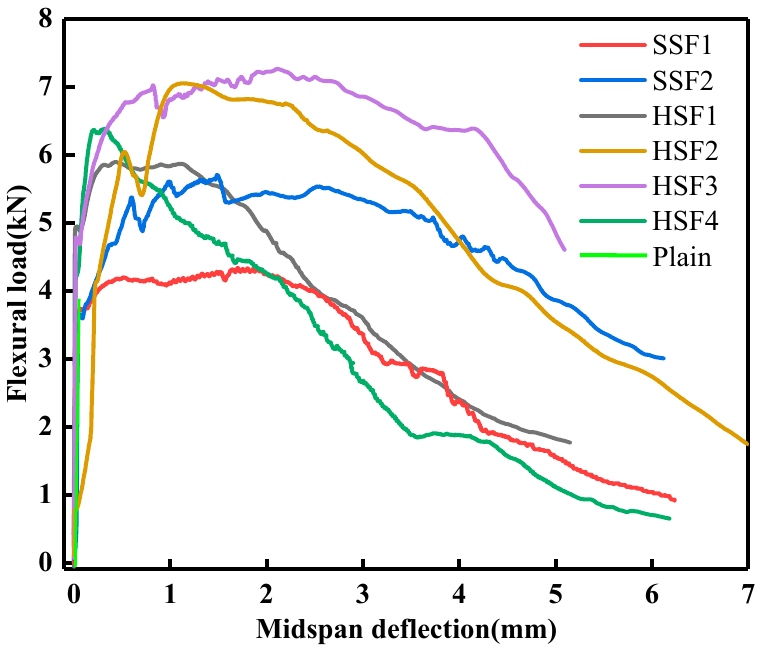
Figure 6. Load–deflection of FRC. Flexural toughness was calculated according to the standard (Standard for Fiber Con- crete Test Methods) CECS13-2009, which includes flexural toughness index and equivalent compressive strength. where, f cr is the initial crack strength, Mpa, F cr is the initial load, N, L is the span, mm. The toughness index of the specimen was calculated according to Formulas (2)–(4).